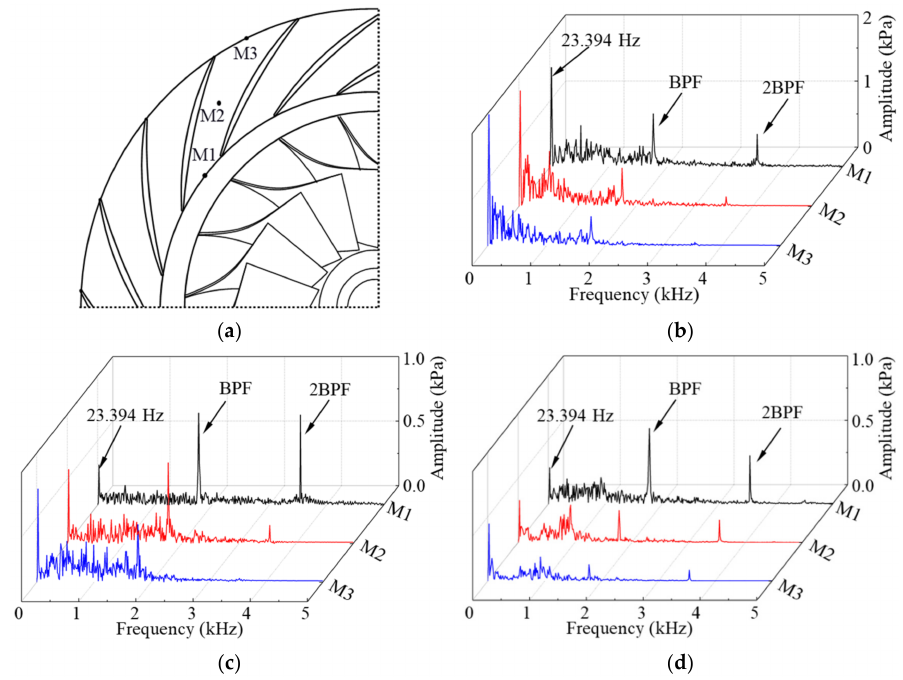
Figure 13. Spectrum analysis of pressure fluctuations at the monitor points in the diffuser passage